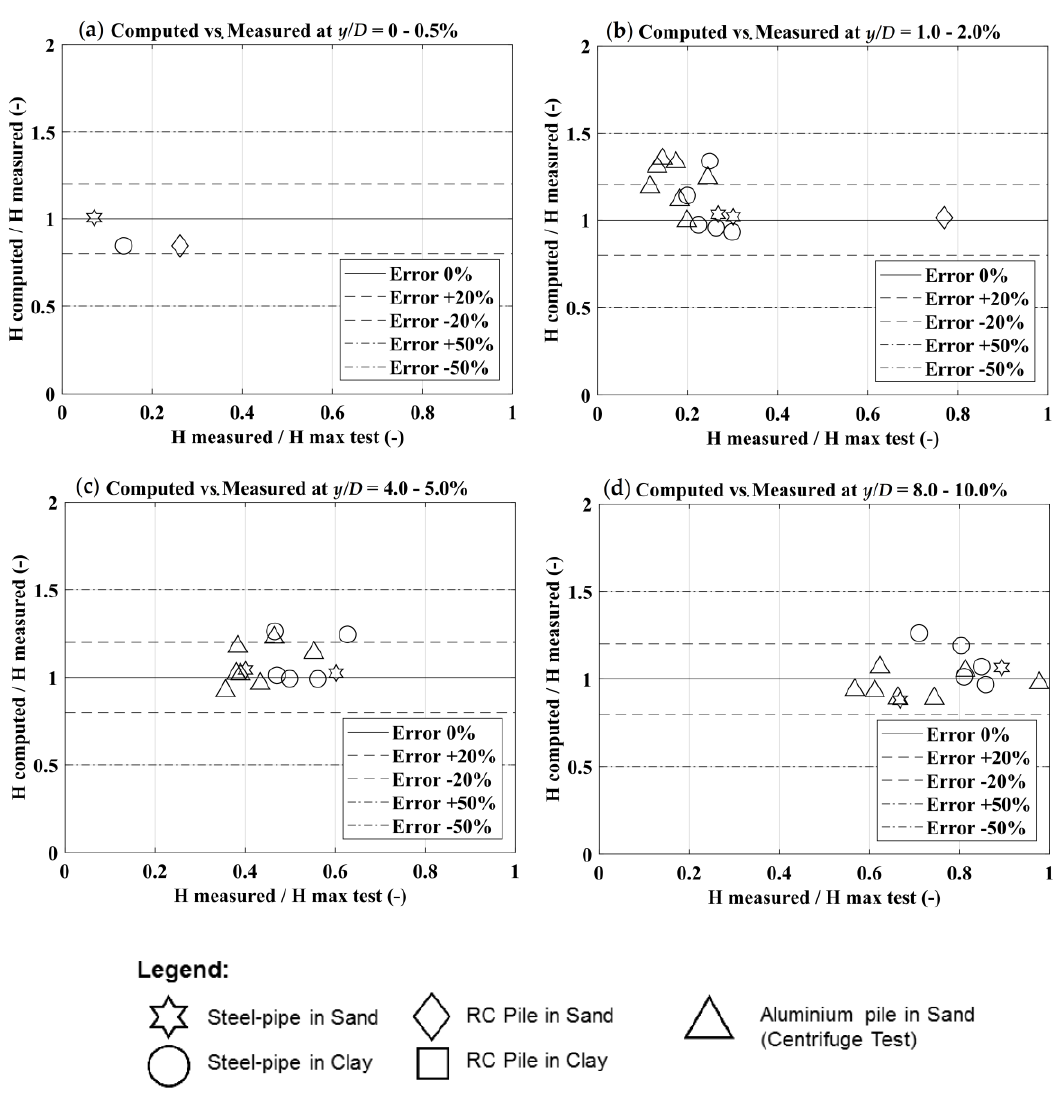
Figure 11. Measured vs. computed horizontal loads (H) for a given normalized displacement ( y/D ): ( a ) y/D = 0–0.5%; ( b ) y/D = 1.0–2.0%; ( c ) y/D = 4.0–5.0%; ( d ) y/D = 8.0–10.0%.